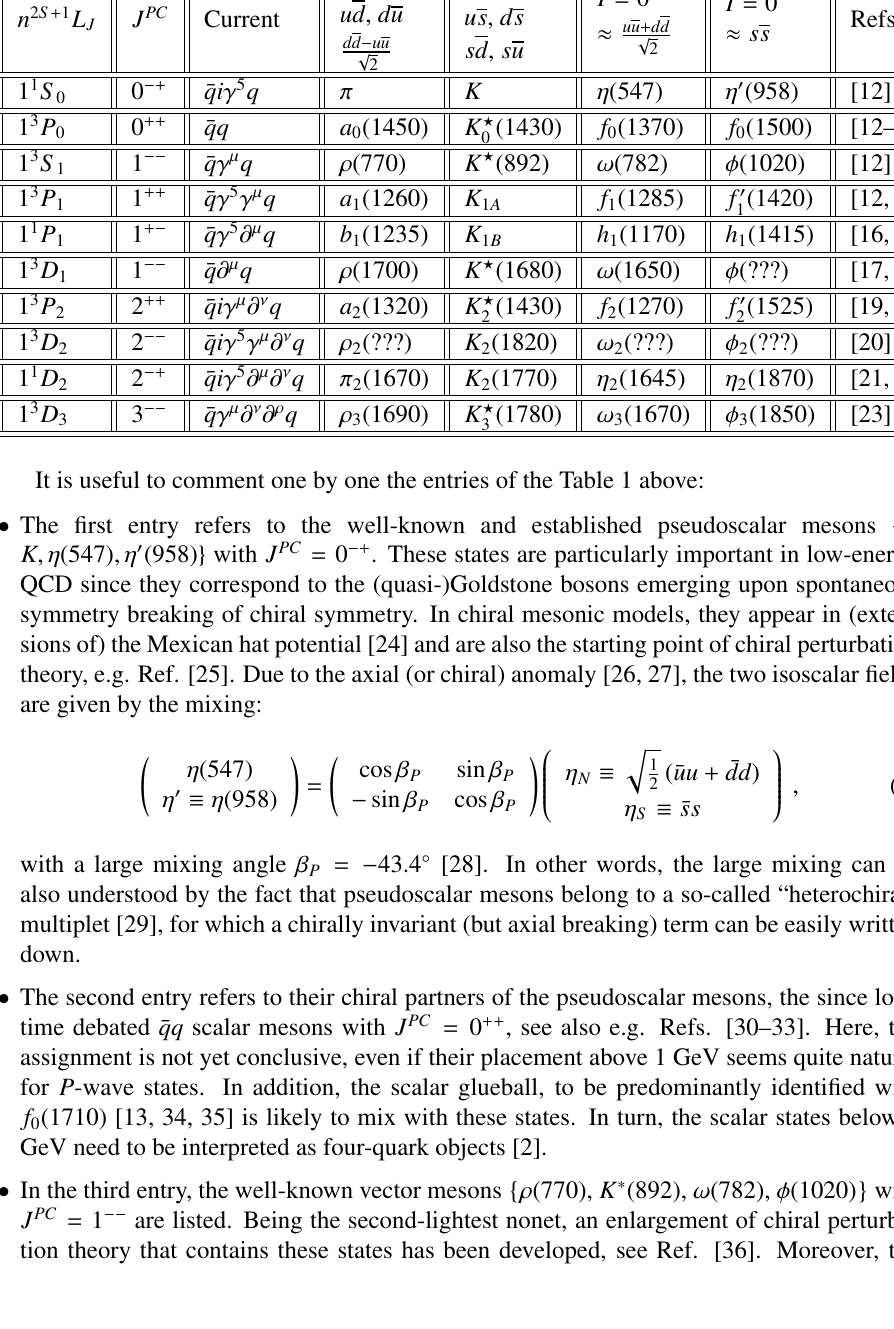
Table 1: Summary of conventional mesons and related references based on hadronic models. n 2 S + 1 L J J